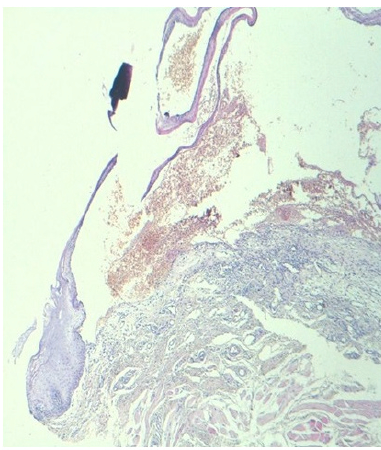
Figure 2. Subepithelial blister and a few inflammatory cells seen in routine hematoxylin and eosin section (10x). The subepithelial space was filled with